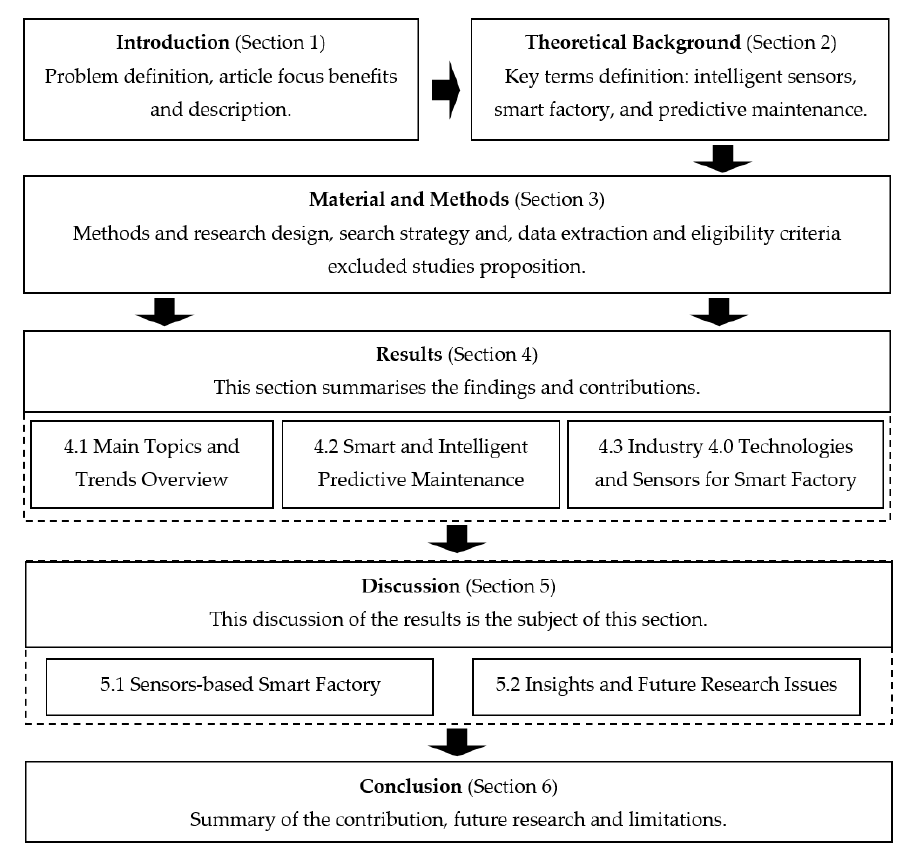
Figure 1. Organisation of the article.